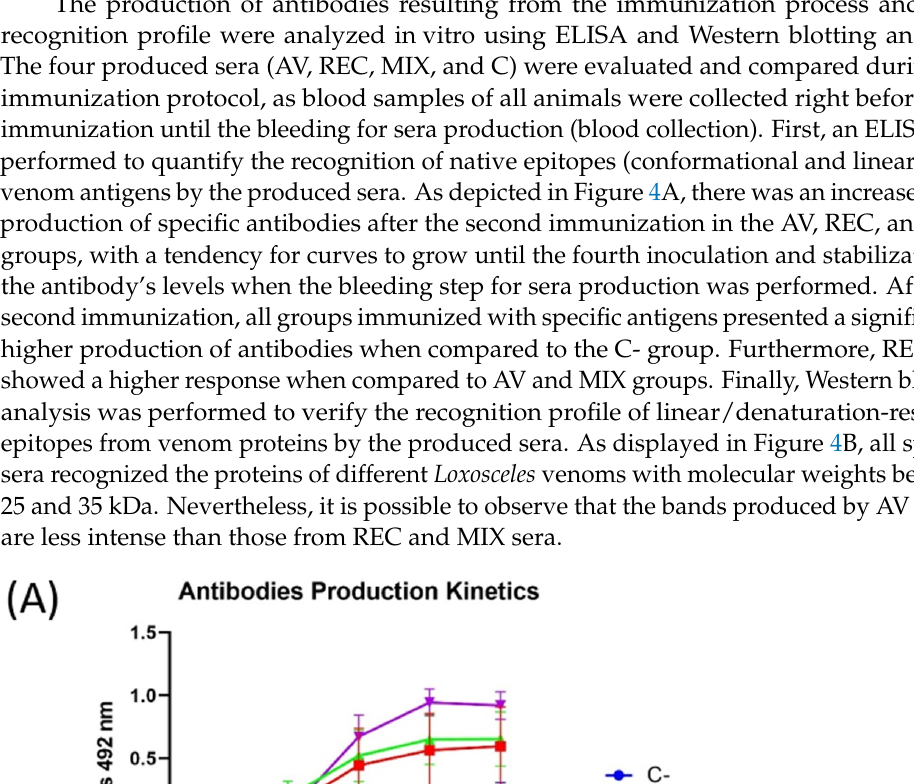
Figure 4. Reaction of produced sera with Loxosceles venoms. ( A ) ELISA for antibody capture assay with plates coated with L. intermedia venom (600 ng/well) and reacted with sera collected immedi- ately before each immunization step (1:400 dilution). Antivenom: AV serum. Recombinant proteins: REC serum. Mix: MIX serum. C-: C serum. A pre-immune serum was used as control. Samples were analyzed in triplicates, and each point represents the mean ± SD. Results were statistically signifi- cant for all groups compared with C- (ANOVA, p < 0.0001). Results of Recombinant proteins’ group were statistically different from all other groups (ANOVA, p < 0.0001). No significant difference was found between Antivenom and Mix groups. ( B ) Western blotting showing immunological cross- reactivity among Loxosceles venoms and produced sera. Samples of venom (10 µg) from L. gaucho , L. intermedia, and L. laeta were probed with the produced sera (1:1000 dilution). R: REC serum. M: MIX serum. V: AV serum. C: C serum. A pre-immune serum was also used as control. Molecular protein mass standards are shown on the left of figures. 3.4. Neutralization of In Vivo Toxicity In order to verify if the produced sera are able to neutralize the main local signs of cutaneous loxoscelism, two neutralization assays were performed. The first one examined the effects of a Loxosceles venom pre-incubated with the produced sera in rabbits’ dorsum skin (Figures 5 and 6). The second assay evaluated if Loxosceles venom inoculated intra- dermally in the ear pinna of rabbits could be neutralized by the produced sera injected intravenously (Figure 7). In the pre-incubation experiment performed in the skin of rabbits, two different amounts of L. intermedia venom were tested (1 MND and 2 MND) and analyzed separately